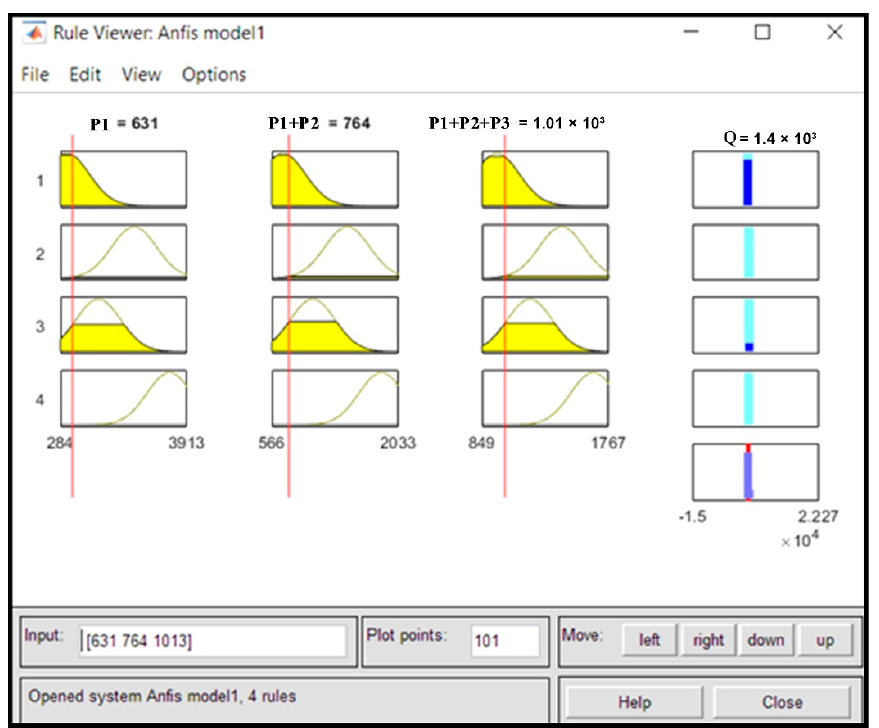
Figure 11. Anfis rule creation.